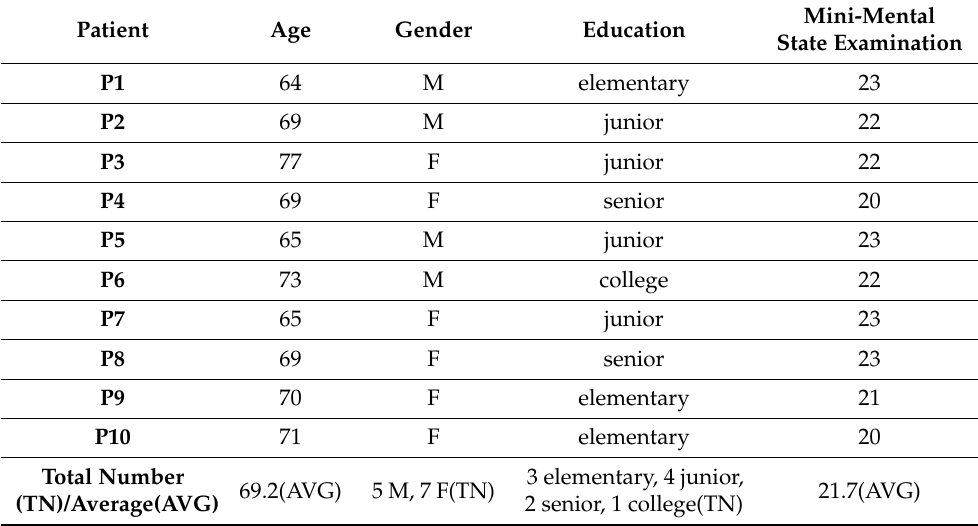
Table 1. Details of the patient